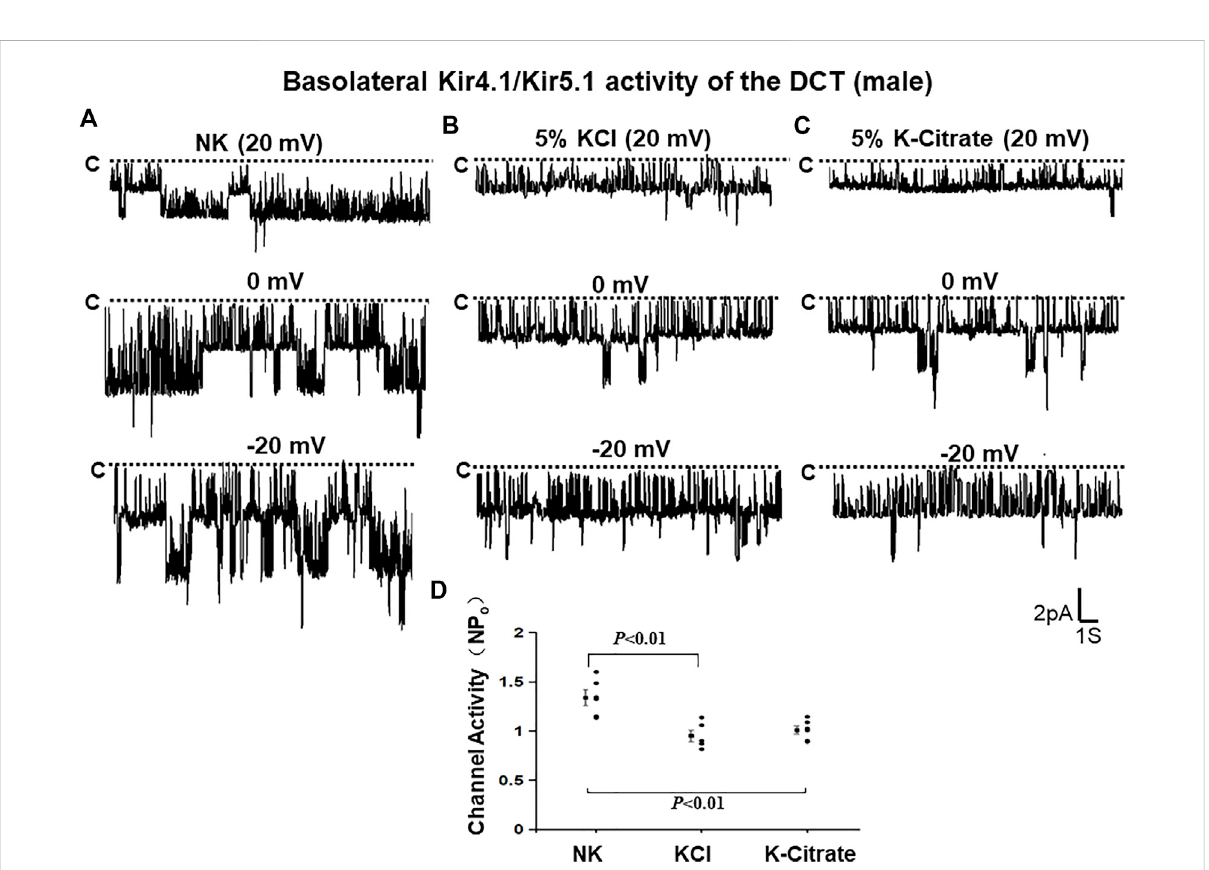
FIGURE 1 HKsimilarlyinhibitsKir4.1/Kir5.1oftheDCTinmalemiceregardlessCl − content.Asetofsingle-channelrecordingsshowsthebasolateral40 pS K + channelactivityintheDCTofmalemiceonNK(normalK + ,1%K) (A) ,5%K-Cl (B) ,and5%K-citratediet (C) for7 days,respectively. (D) Ascatterplot summarizing each data point and mean value of NP o measured at 0 mV. The channel closed level is indicated by “ C ” and a dotted line. The holding potential for the patch-clamp is indicated on the top of each trace and it is 20 mV, 0 mV, and -20 mV, respectively. The bath solution contains 140 mM NaCl and 5 mM KCl and the pipette solution contains 140 mM